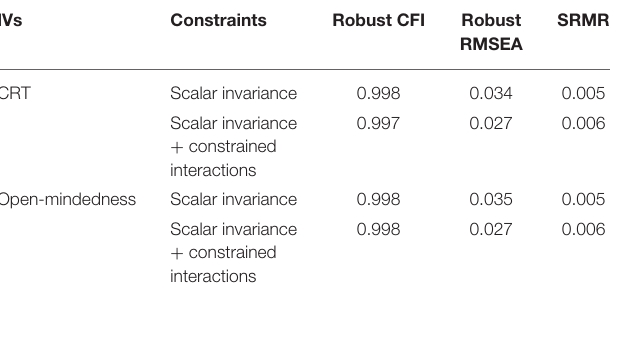
TABLE 5 | Invariance of political orientation as a moderator of the relationship between analytic thinking and COVID-19 preventive behaviors and policy support across the three political contexts ( N = 12,490).